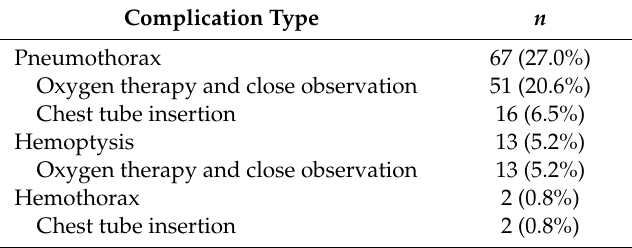
Table 4. Complication of PTNB ( n = 248).